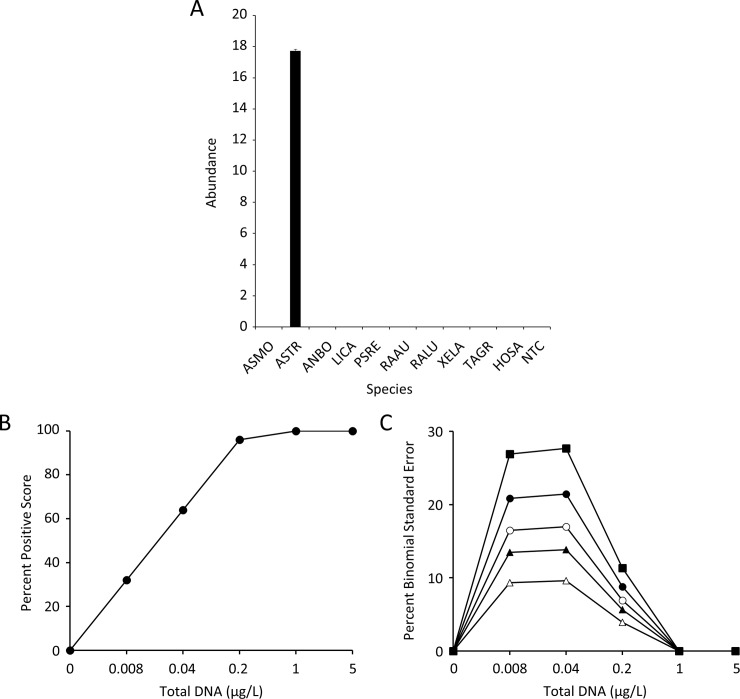
The eASTR4 test is highly specific for coastal tailed frog and is highly sensitive.A) The sensitivity graph is displayed as mean abundance with standard error of the mean of n = 25 technical replicates of each species (refer to Table 1 for legend) and a no template control (NTC). Five μg/L total DNA were tested and the strength of detection (Abundance) was determined as the number of cycles (50) in the qPCR program minus the cycle threshold where detection occurred. B) The sensitivity graph was produced using a 5-fold dilution series of total DNA of the target species. The percent positive score is derived from the number of detected reactions divided by the number of technical replicates (n = 25). C) Percent binomial standard error determined at each dilution of total DNA for differing technical replicates: n = 3 (solid squares), n = 5 (solid circles), n = 8 (open circles), n = 12 (solid triangles), and n = 25 (open triangles).